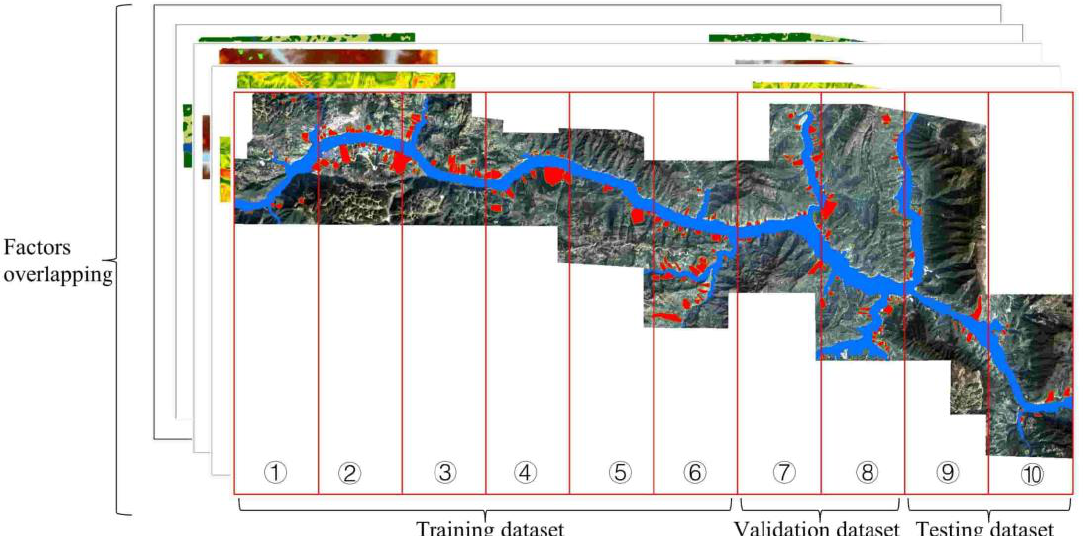
Figure 7. Diagram of dataset splitting.